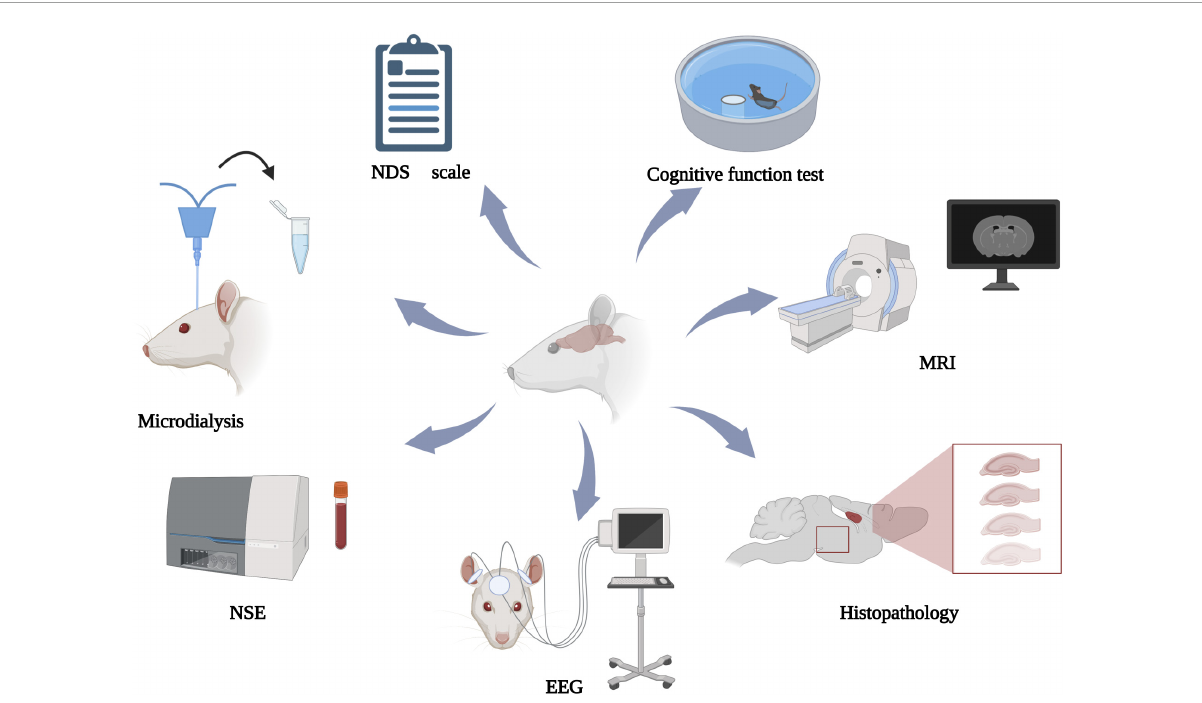
FIGURE2 Multimodal neural monitoring diagram. NDS, neurologic deficit score; NSE, neuron-specific enolase; EEG, electroencephalogram; MRI, magnetic resonance. Created with